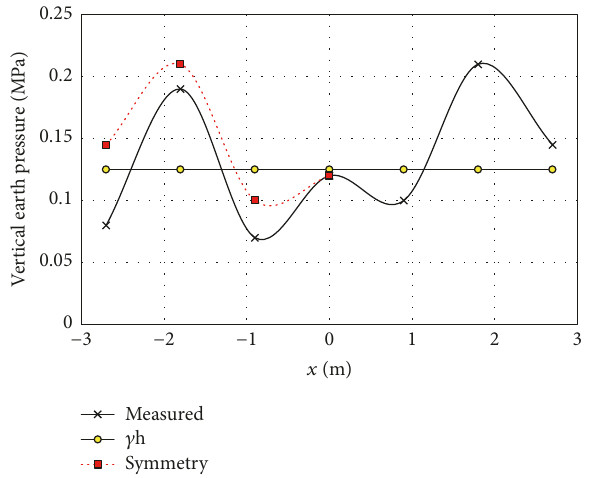
Figure 16: Vertical earth pressure on slab under 7 m filling.